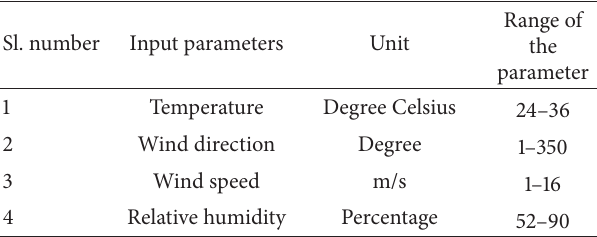
Table 1: Details of the wind input parameters for the proposed